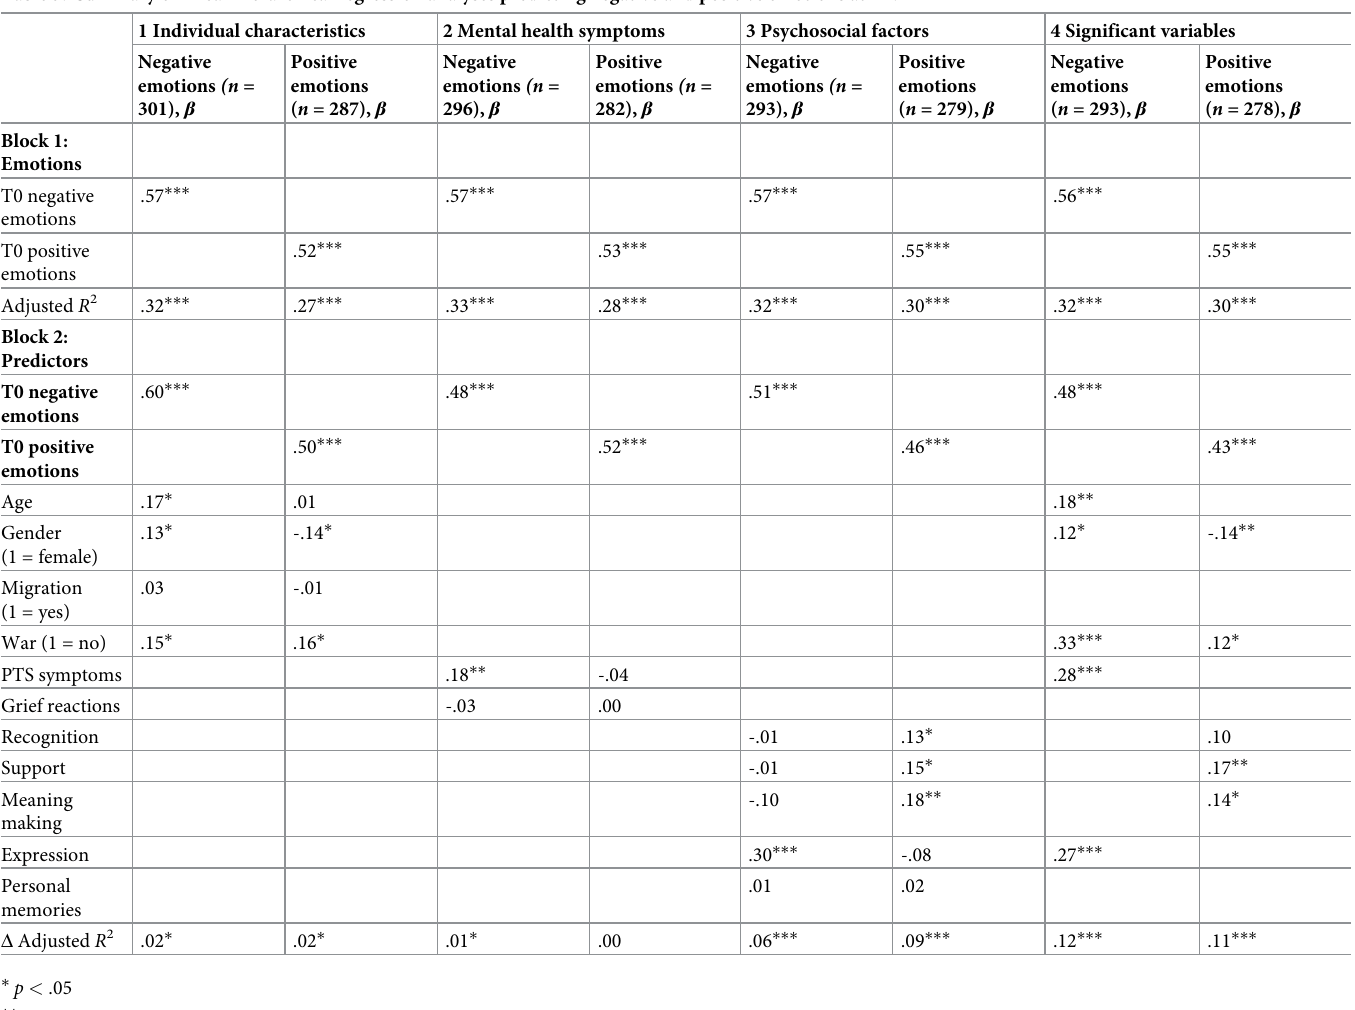
Table 5. Summary of linear hierarchical regression analyses predicting negative and positive emotions at